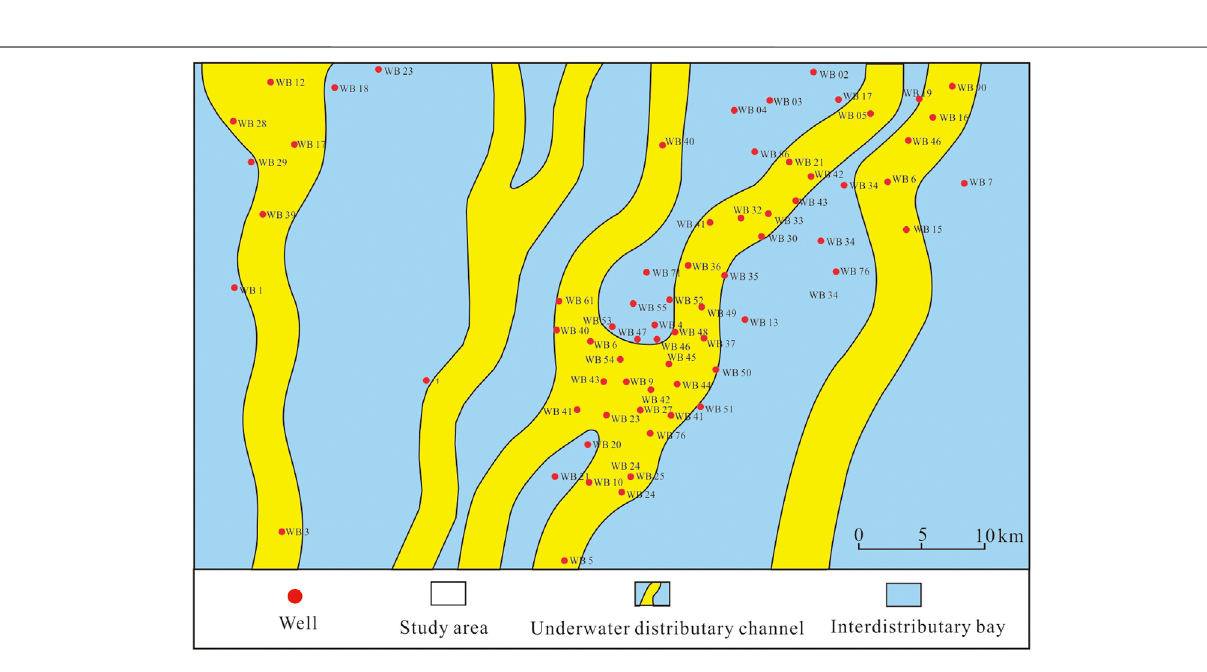
Frontiers in Earth Science |